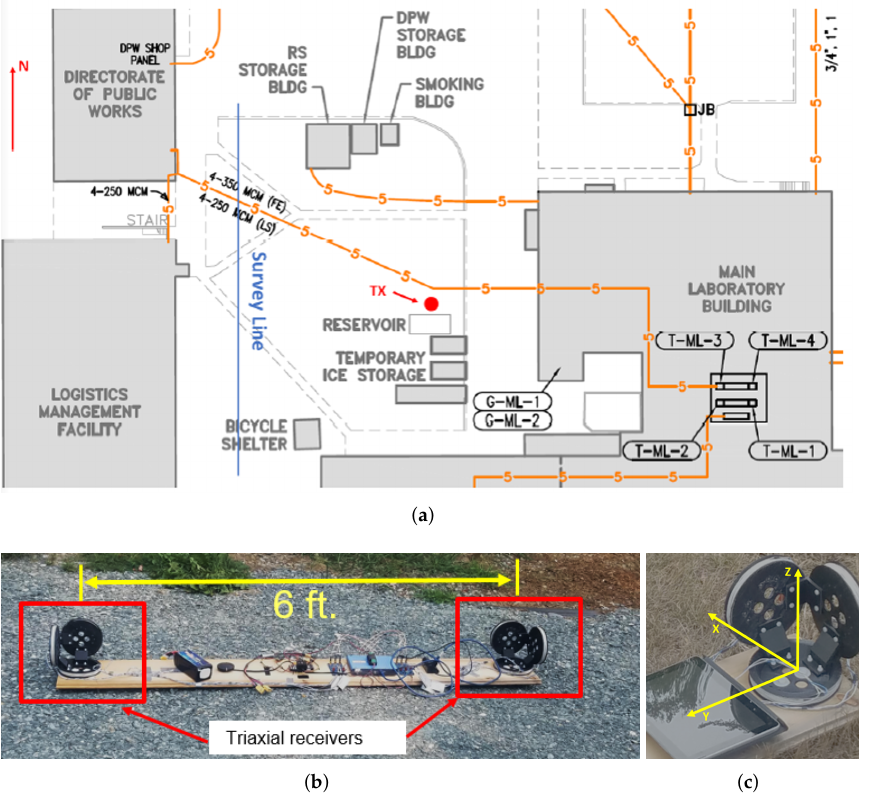
Figure 11. A theoretical survey walk and our built triaxial gradiometer sensor. ( a ) Theoretical survey walk. ( b ) Gradiometer sensor. ( c ) Triaxial